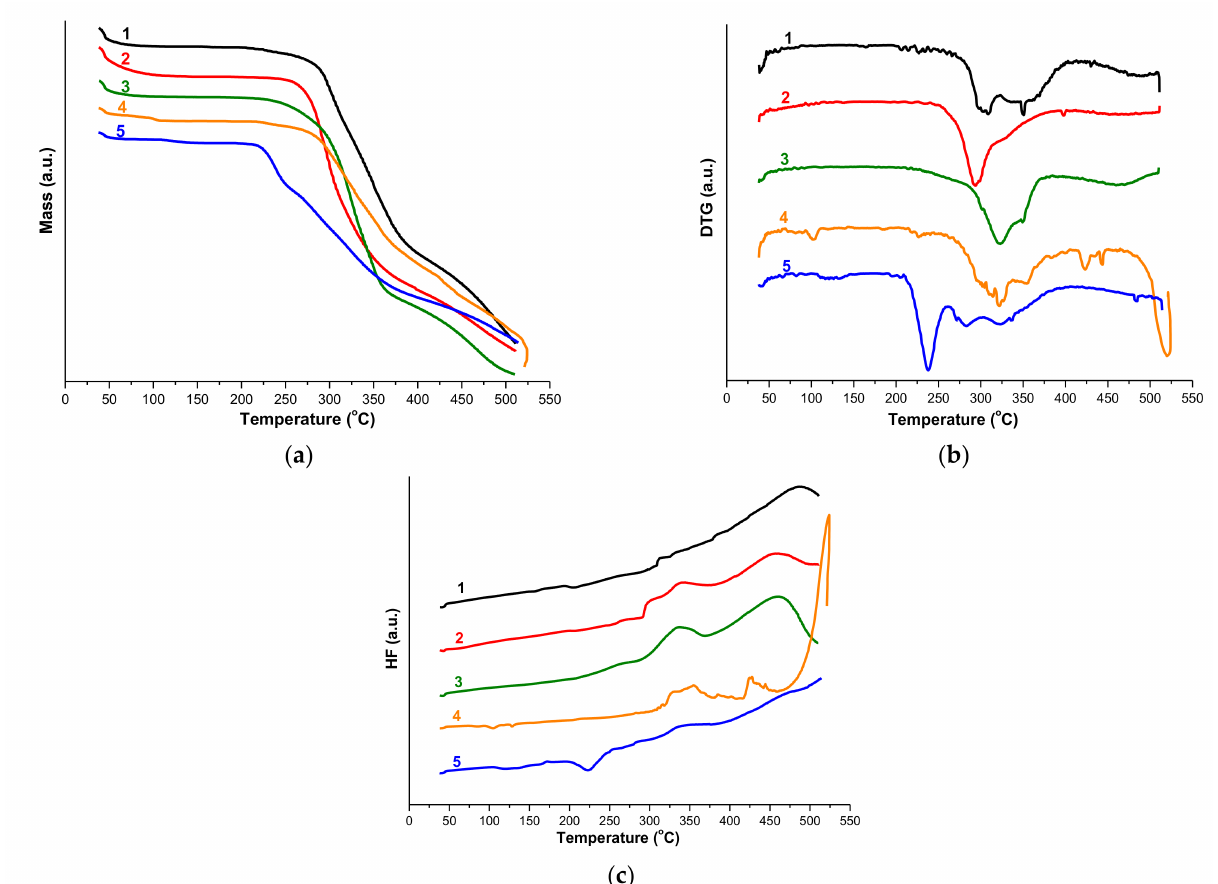
Figure 8. TG ( a ), DTG ( b ), and HF ( c ) curves of RSP/RM- β -CD inclusion complex (1) and its mixtures with excipients, as follows: RSP/RM- β -CD + STR (2); RSP/RM- β -CD + CEL (3); RSP/RM- β -CD + MgSTE (4); RSP/RM- β -CD + LCT